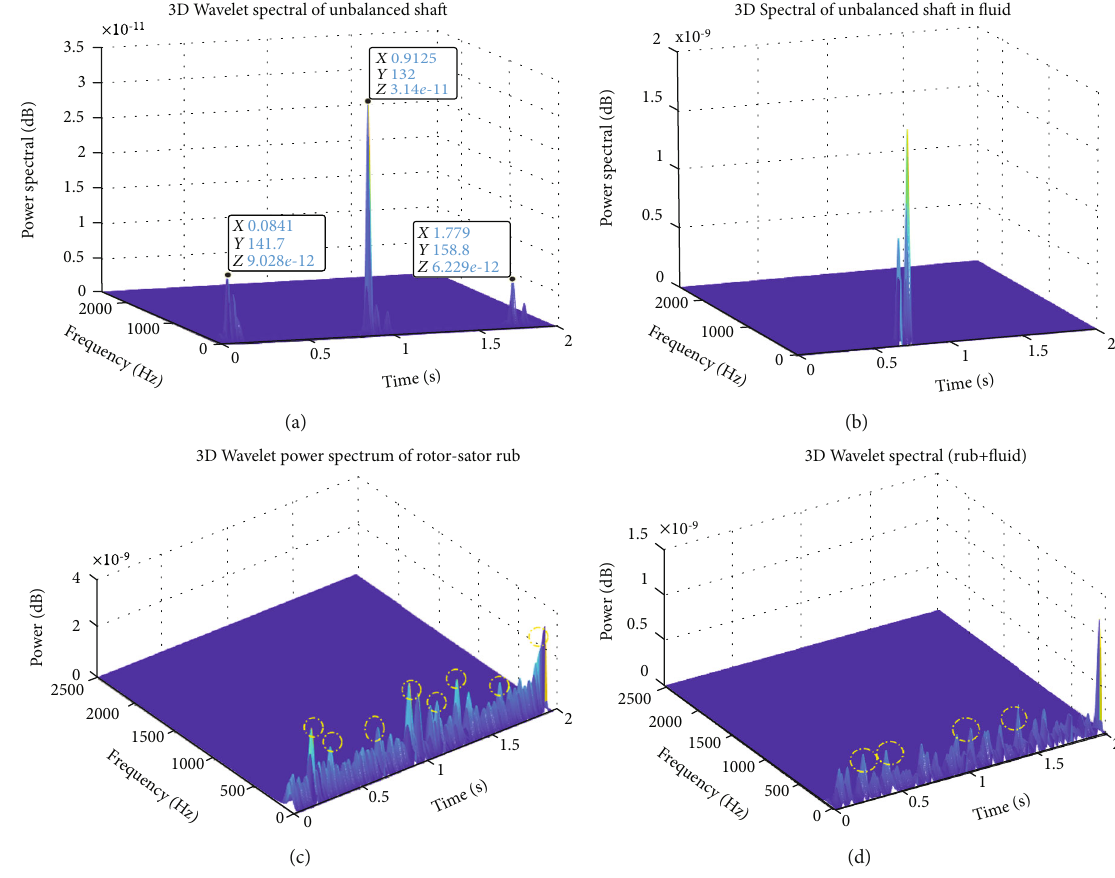
Figure 8: Corresponding 3D wavelet synchrosqueezing spectrum (NWSST) of the rotor system.